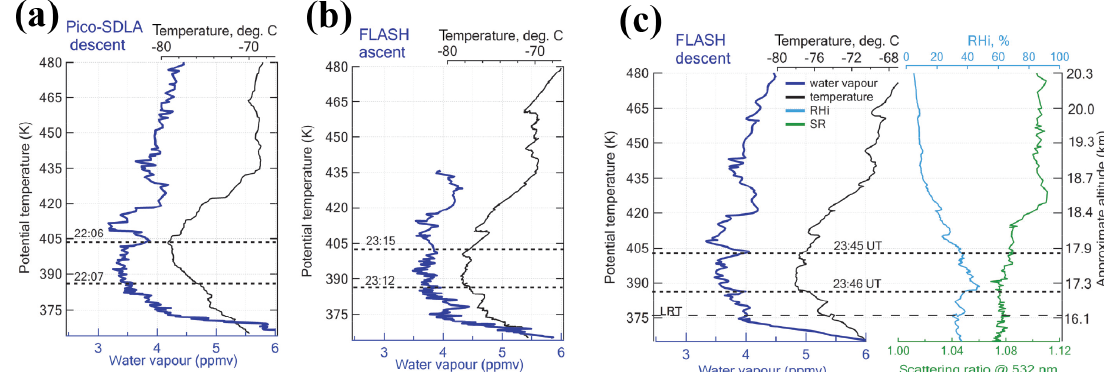
Figure 4. Water vapour (blue) and temperature (black) vertical profiles obtained successively in time on 13 March by (a) Pico-SDLA on descent, (b) FLASH-B on ascent (outgassing-biased part removed), (c) FLASH-B on descent. The cyan and green curves in the right-hand panel indicate relative humidity with respect to ice (RHi, top axis, FLASH/RS92) and scattering ratio at 532nm (SR, bottom axis, COBALD). The horizontal dashed lines mark the levels where hydrated layers in (c) were sampled with indication of the sampling time (UTC). The thin dashed line indicates the level of lapse rate tropopause (LRT, 376K).